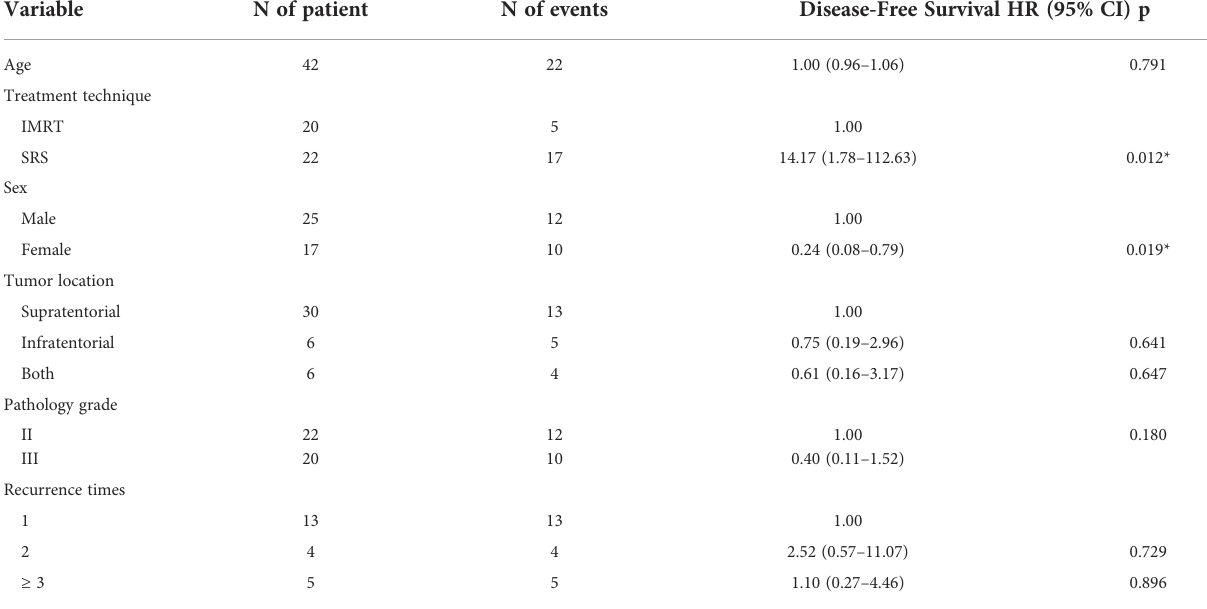
TABLE 2 COX regression analysis of factors associated with disease-free survival in patients with SFT/HPC receiving post-operative radiotherapy.